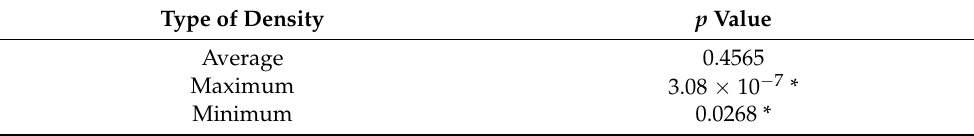
Table 4. p value of ANOVA test for average, maximum, and minimum density of the